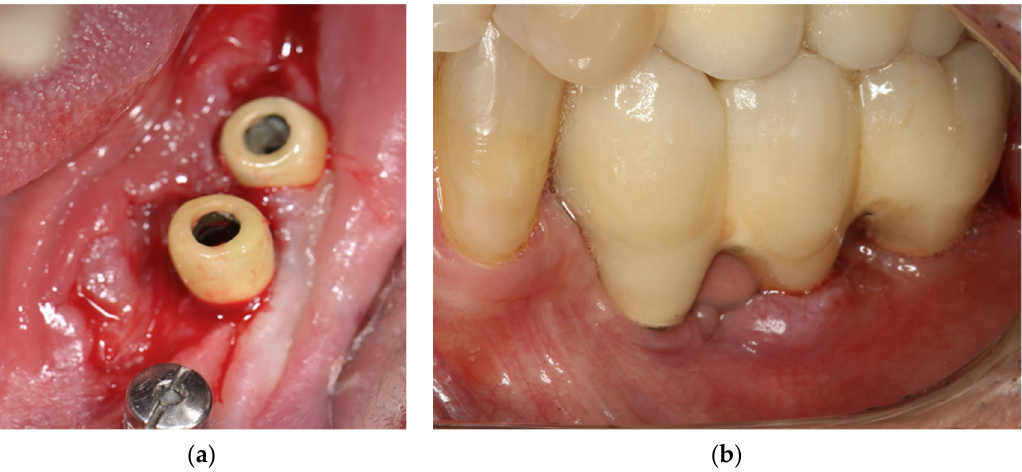
Figure 5. Clinical situation during the healing phase. ( a ) Intraoral view of the peri-implant soft tissues and the plastic healing caps connected to the distal implants after 10 days; ( b ) Intraoral view at the 5-year follow-up recall.